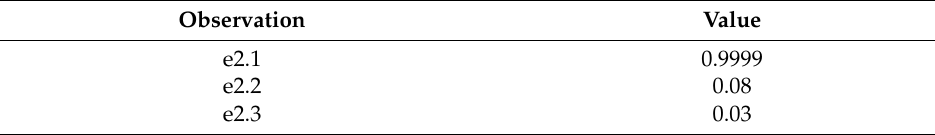
Table 2. Assignment of particular values for observing h2 (prepared by the authors).